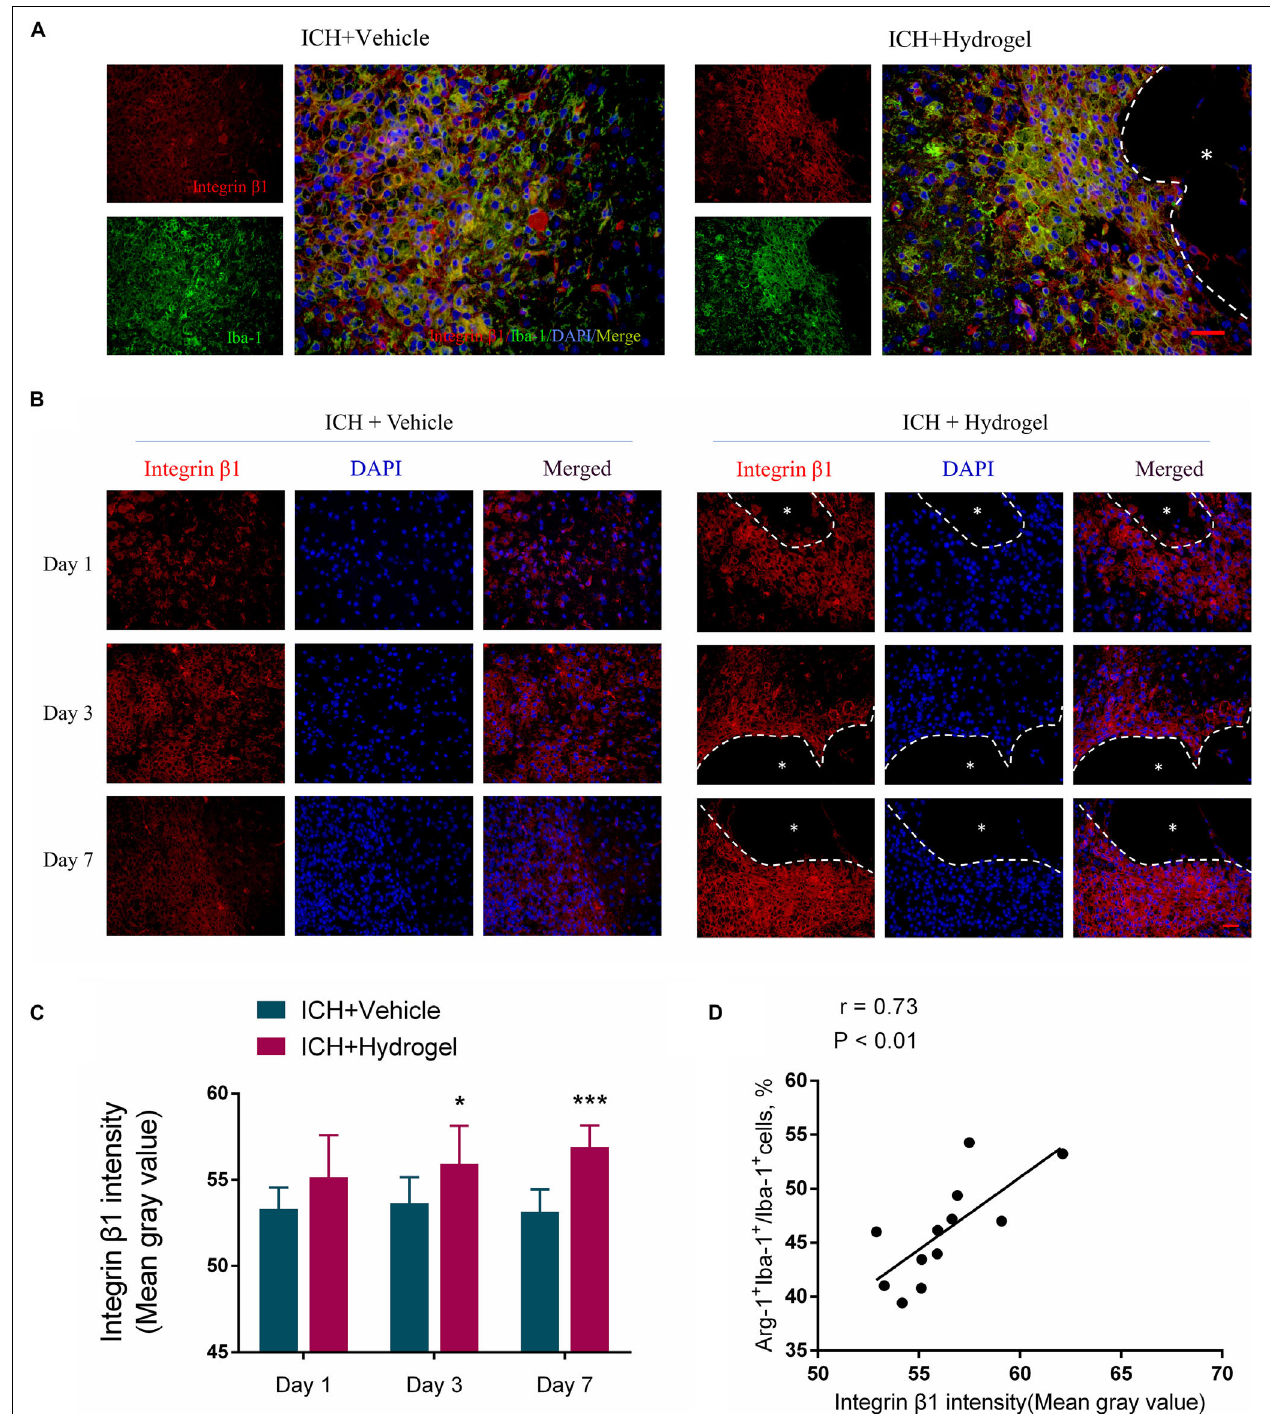
FIGURE 8 | Gelatin hydrogel affects the expression of integrin β 1. (A) Double immunofluorescence staining was performed with integrin β 1 (red) and microglia marker/macrophages Iba-1 (green) in brain sections on day 7, scale bar = 20 µ m. (B) Immunofluorescence staining of integrin β 1 around the lesion, scale bar = 20 µ m. (C) Fluorescence intensity (FI) analysis of the images. (D) The correlation analysis between the Arg + IBA + double-positive cells positive percentage and fluorescence intensity of β 1, the correlation coefficient is 0.73 ( P < 0.01). *Represents the hydrogel. Data are mean ± SD, n = 4 mice per group, * P < 0.05, *** P <